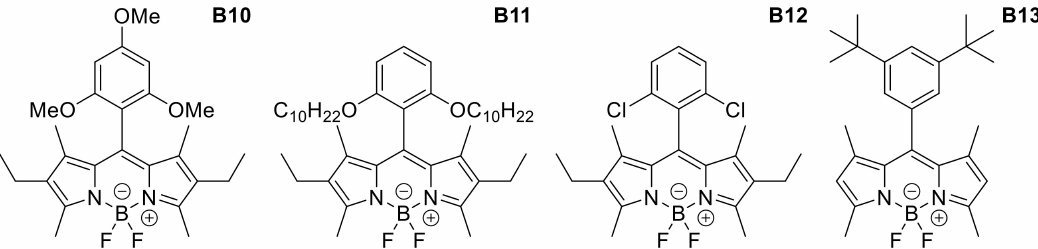
Figure A3. Substituted aromatic groups placed at the meso position.